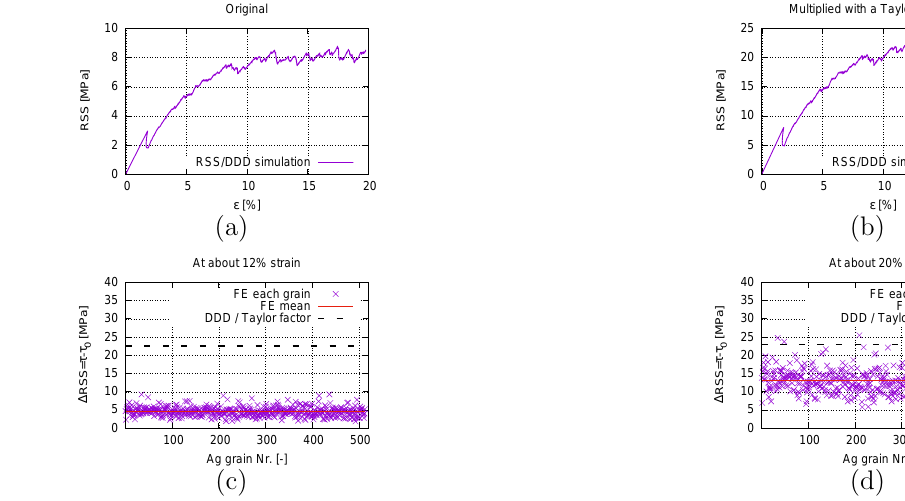
Figure 17. Predicted RSS and ∆ RSS: ( a ) RSS flow behavior from DDD simulation; ( b ) the same as ( a ) multiplied by a Taylor factor to compare with FE results; ( c ) at 12% strain, ∆ RSS ( ∆ τ = τ in 513 Ag grains and the Ag phase mean values from FE and DDD simulation (multiplied by a Taylor factor of 2.71); (d) analogous to (c), but at 20% strain.